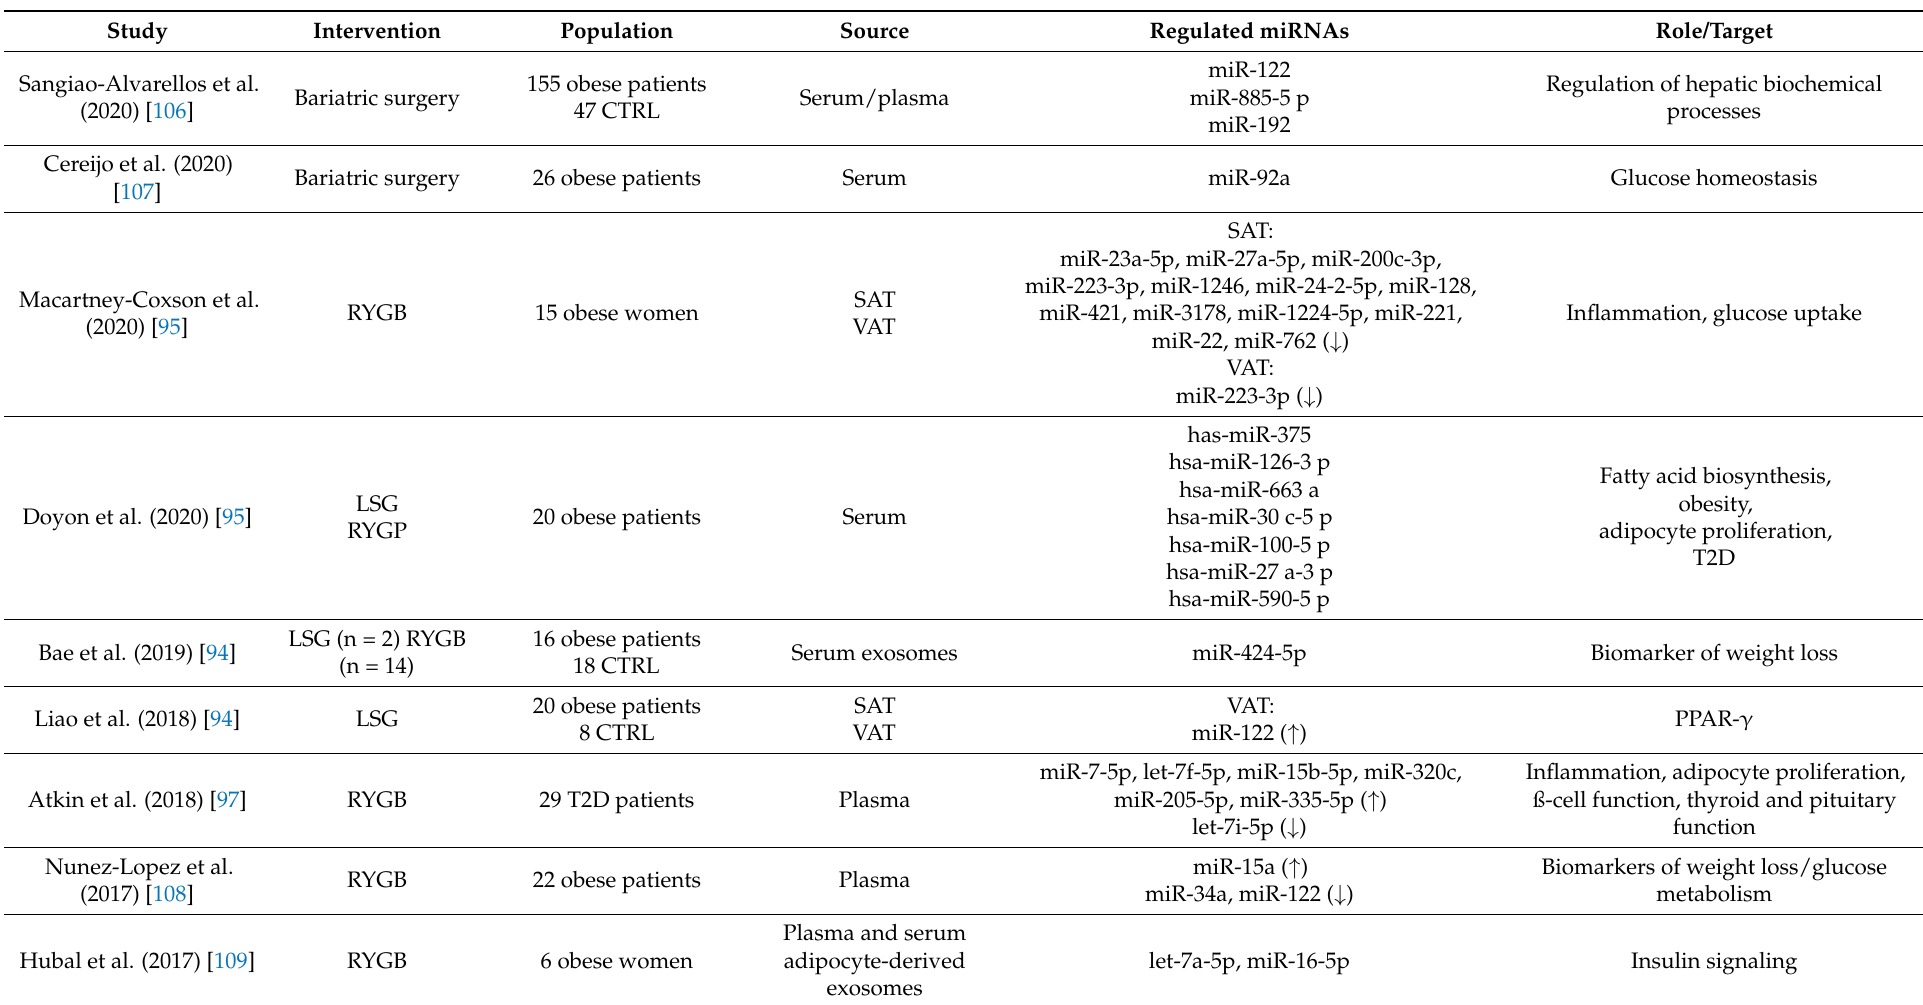
Table 2. Differentially expressed miRNAs with their roles/targets after